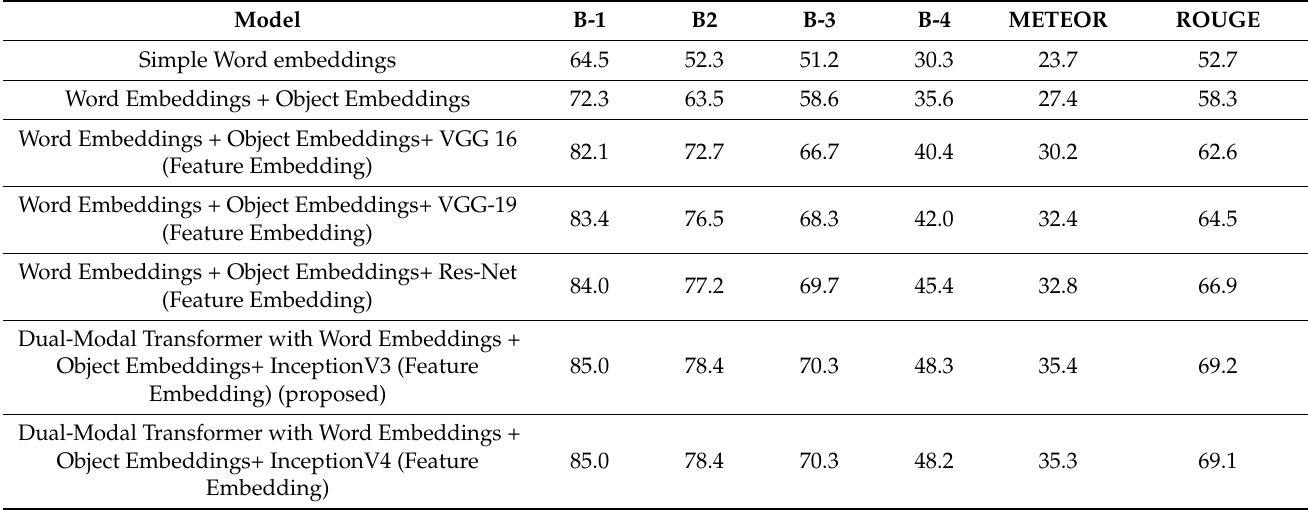
Table 8. Ablation study results used to decide the proposed